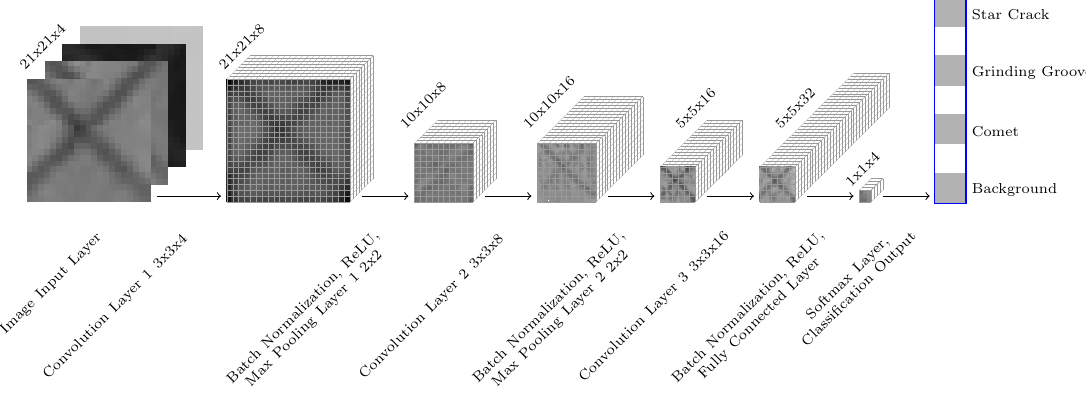
Figure 3. Simple convolutional neural network architecture for classifying our 21 × 21 × 4 image stacks of wafer back surface